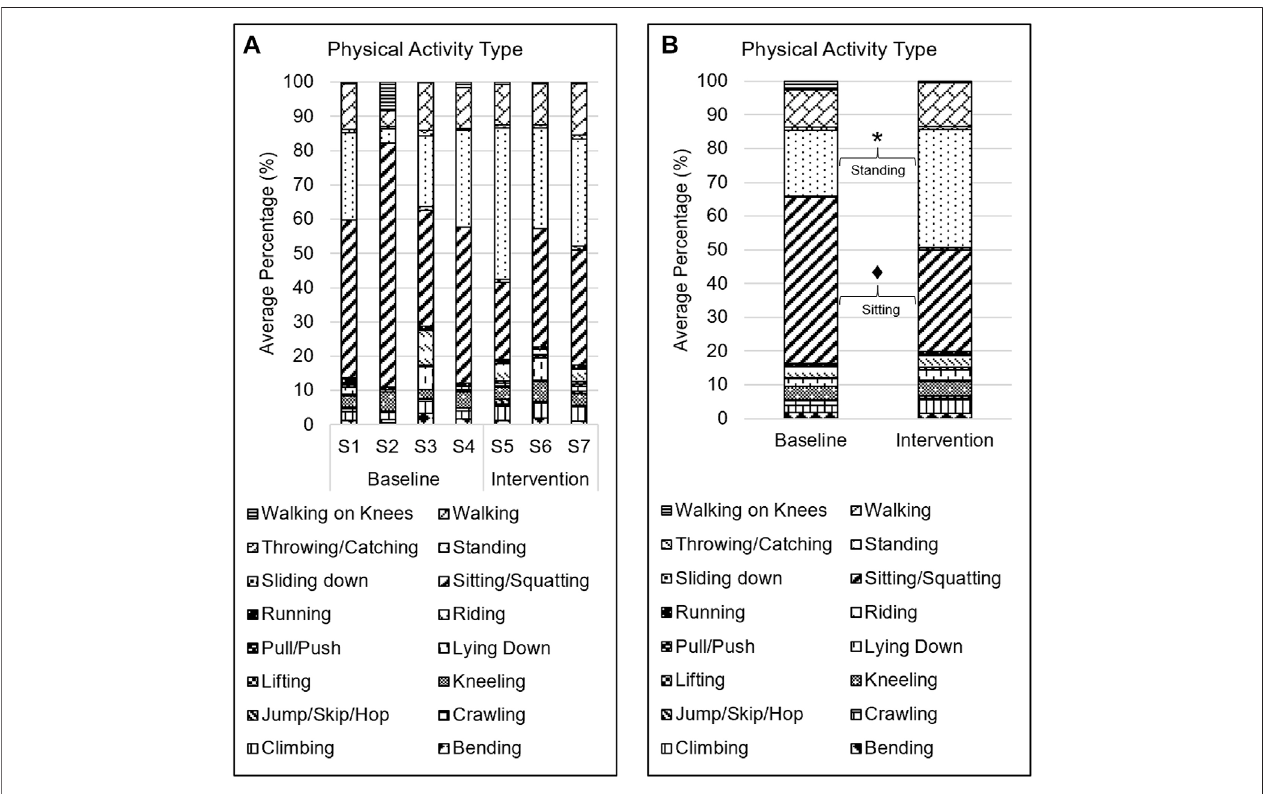
FIGURE2| Physicalactivitytype. A .Averagepercentageofintervalsspentineachtypeofphysicalactivityacrosssessions.S#onthex-axisrepresentsthesession number. B . Average percentage of intervals spent in each type of physical activity during baseline and intervention phases. * → p < 0.05; ◆ → p < 0.06.